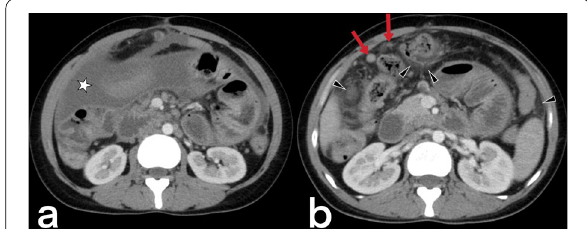
Fig. 27 A 33-year-old female. Axial post-contrast CT images ( a , b ) demonstrate omental nodularity, mesenteric fat stranding (arrowheads), and ascites (star). Intraabdominal lymphadenopathies are also evident (arrows) in image b